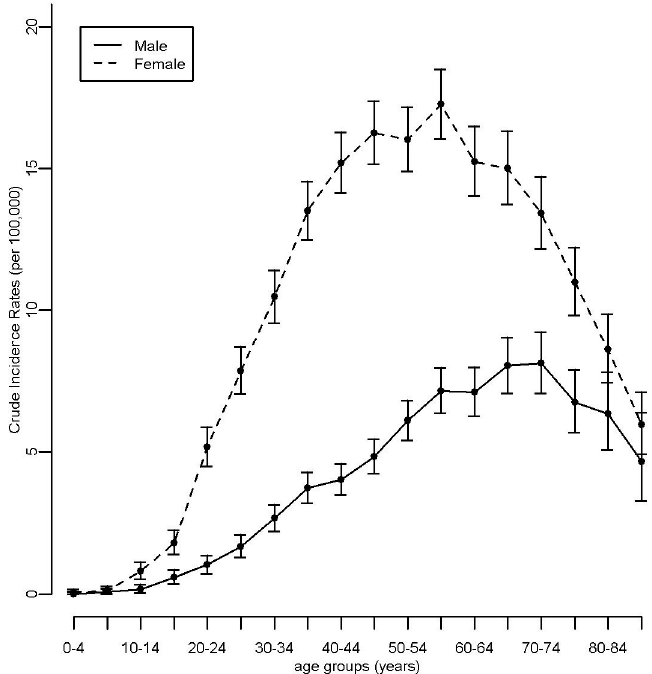
Figure 1. Age- and sex-specific incidence rates of thyroid cancer in Belgium, 2000/2004–2014.